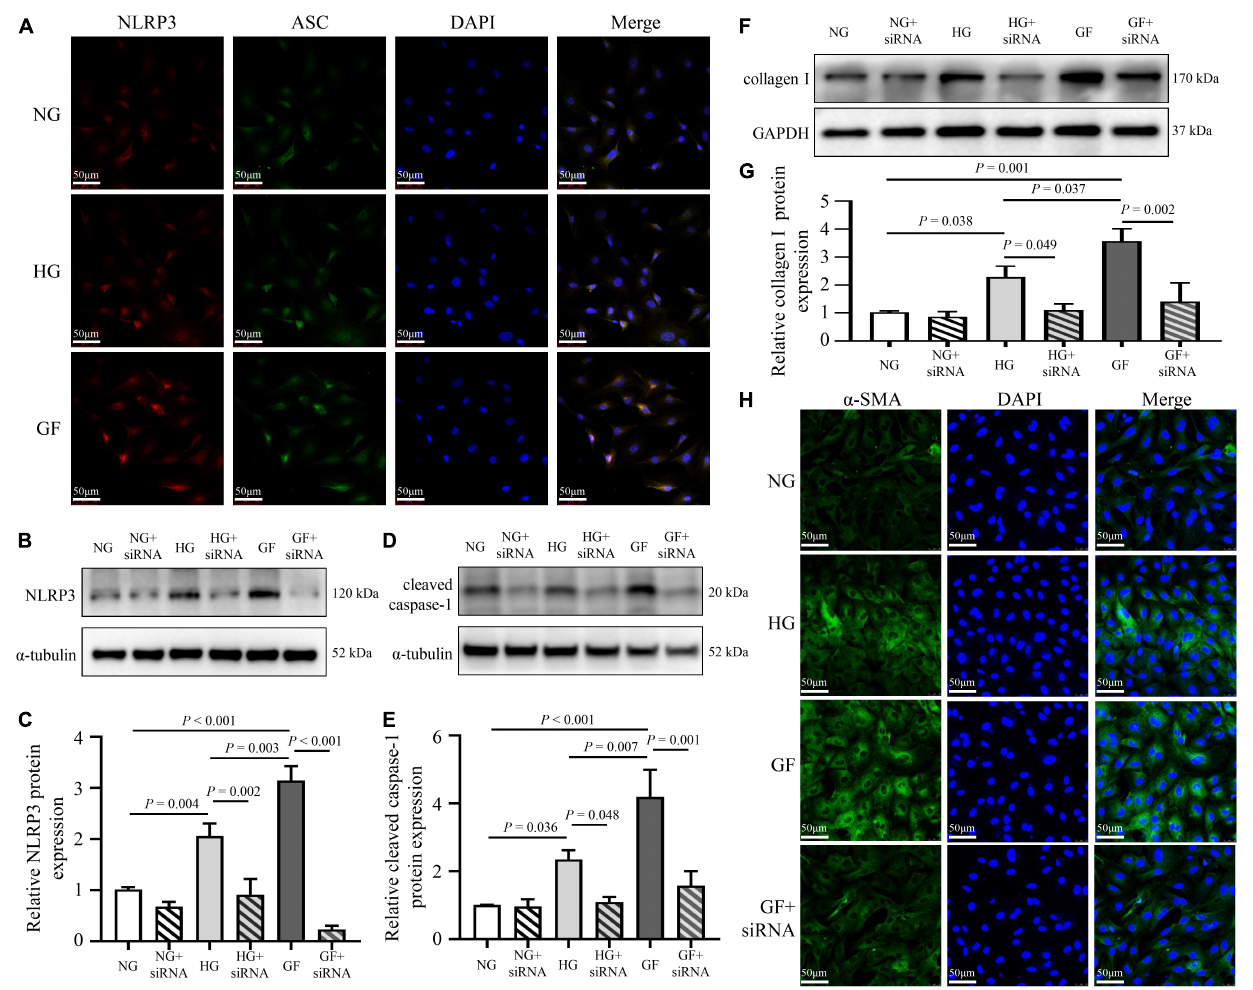
FIGURE 4 | Role of inflammasome in glucose fluctuation-induced myocardial fibrosis. (A) Immunofluorescence staining of intracellular NLRP3–ASC interaction examined by confocal microscopy. The NRCFs were labeled with anti-NLRP3 (red), anti-ASC (green), and DAPI (blue) ( n = 3 per group). (B–G) After siRNA targeting NLRP3 transfection, the protein expressions of NLRP3, cleaved caspase-1 and collagen I were measured by western blot ( n = 3 per group). (H) Representative images of immunofluorescence staining of intracellular α -SMA in the NG, HG, GF, and GF + siRNA groups ( n = 3 per group).